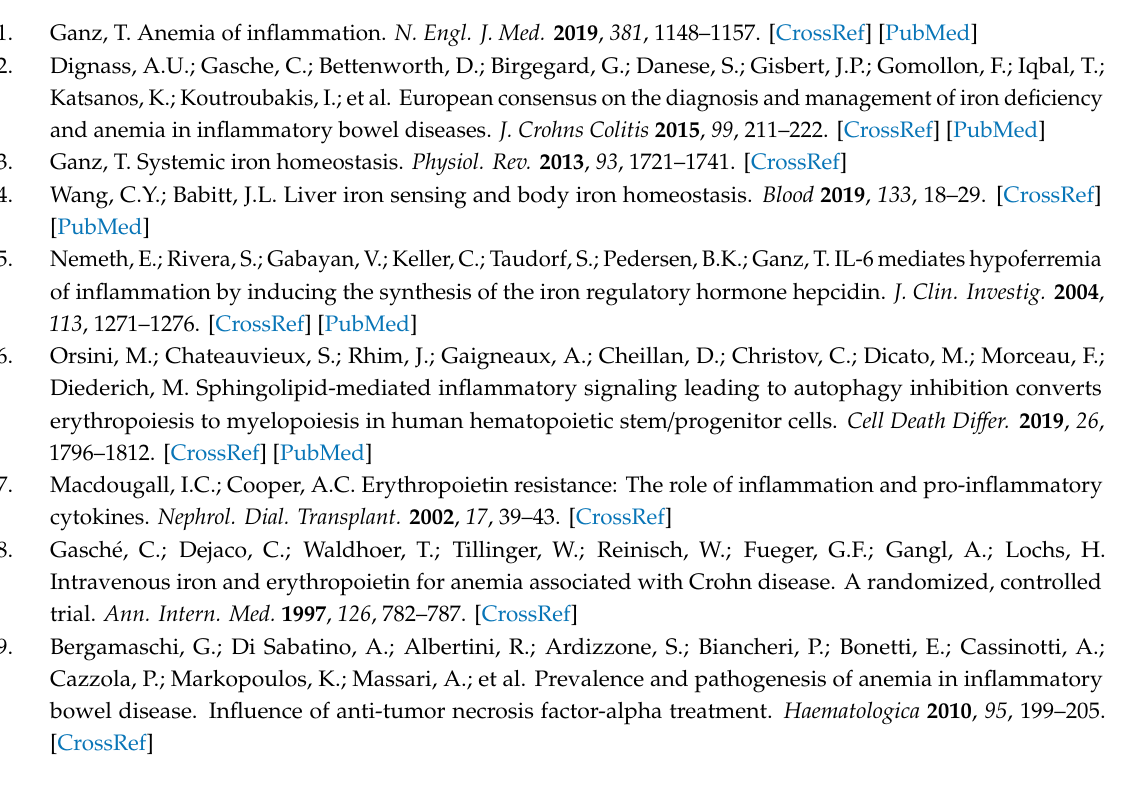
Table S1. Clinical and demographic characteristics of the patients, Table S2. Distribution of